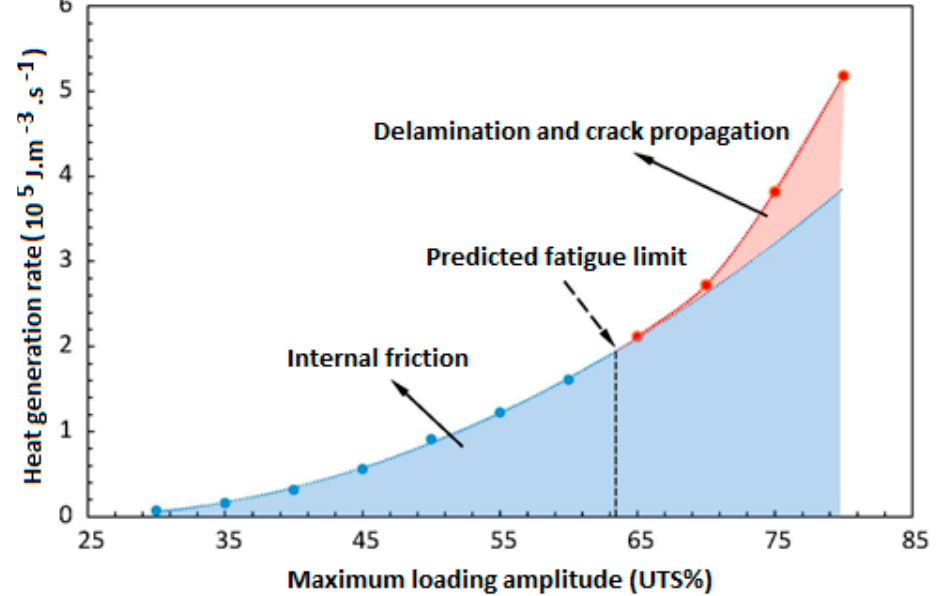
Figure 60. The exemplary illustration of heat generation rates depending on loading amplitude, adapted with permission from Ref. [89]. Copyright © 2020 Elsevier